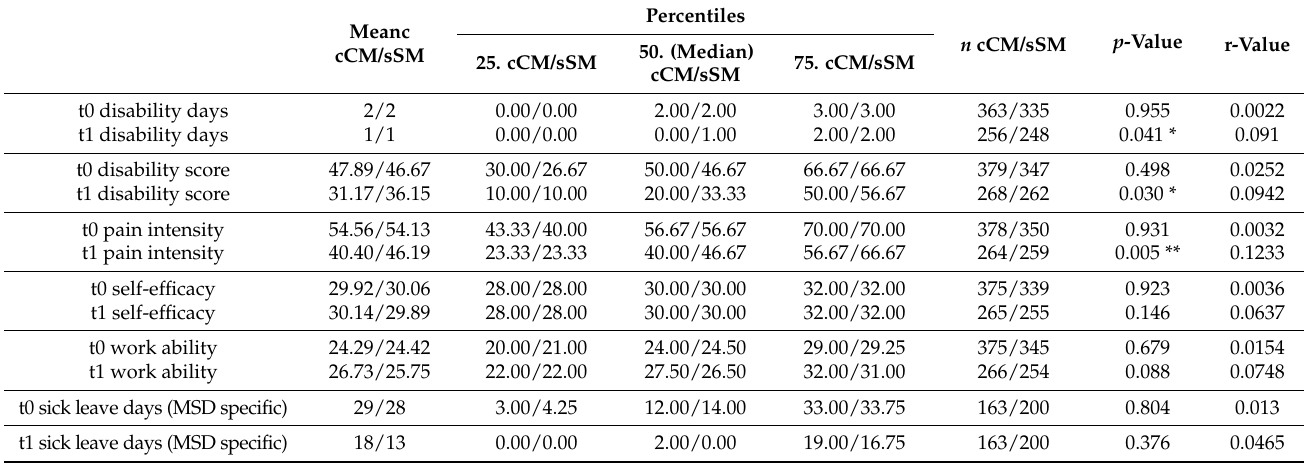
Table 1. Group differences’ analyses: coordinating case management (cCM) vs. supported self-management (sSM) at baseline (t0) and follow-up (t1) (* = p < 0.05, ** = p <